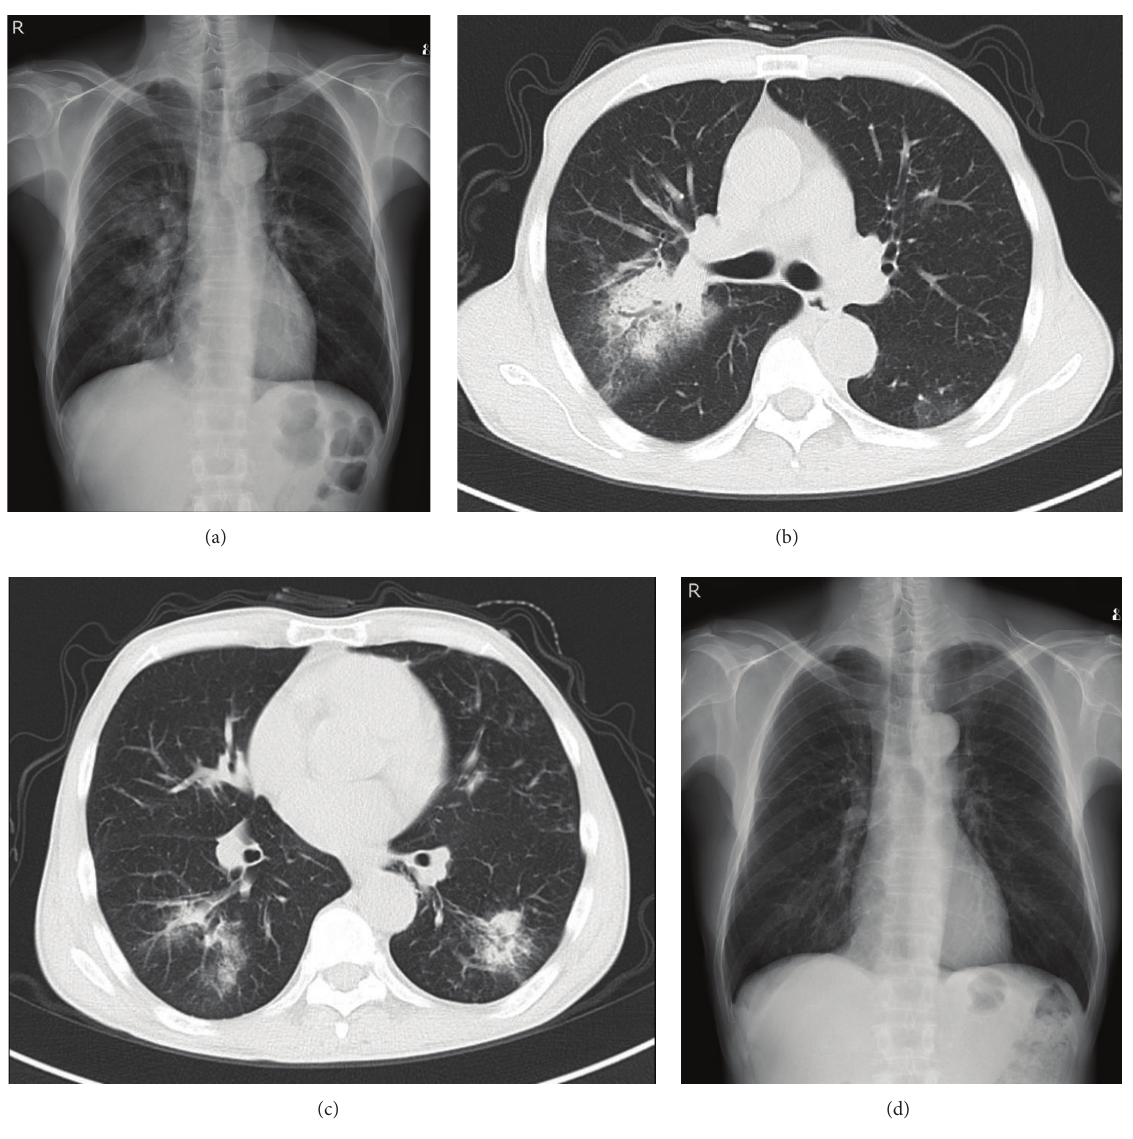
Figure 1: (a) Chest radiograph shows patchy bilateral consolidation in the middle lobe and bilateral lower lobes. (b, c) Chest computed tomography reveals patchy consolidation, ground glass opacities, and small nodular opacities in the middle (b) and bilateral lower lobes (c). (d) Follow-up chest radiograph after 3 weeks shows resolution of abnormal